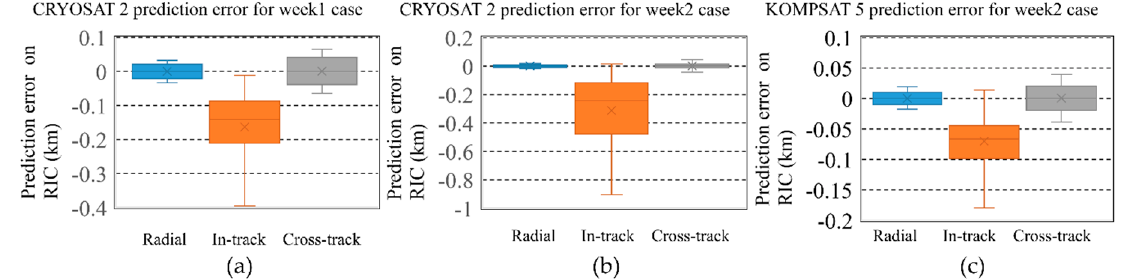
Figure 12. Prediction error for 7 days after multi-arc batch least-squares orbit estimation using 2 weeks of data for CRYOSAT 2 ( a , b ) and 1 week of data for KOMPSAT 5 ( c ). In one case for KOMPSAT 5, there was a maneuver event one day after the optical observation. The maximum prediction errors of two satellites did not exceed 1 km for 7 days.